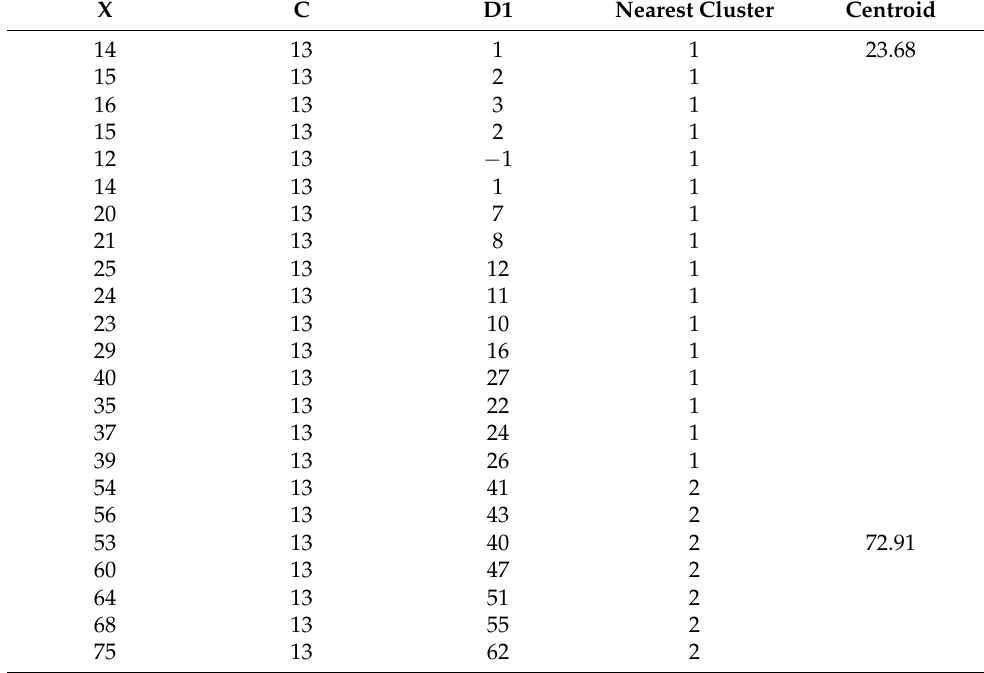
Table 2. Iteration 1—find the centroid values of the nearest cluster.